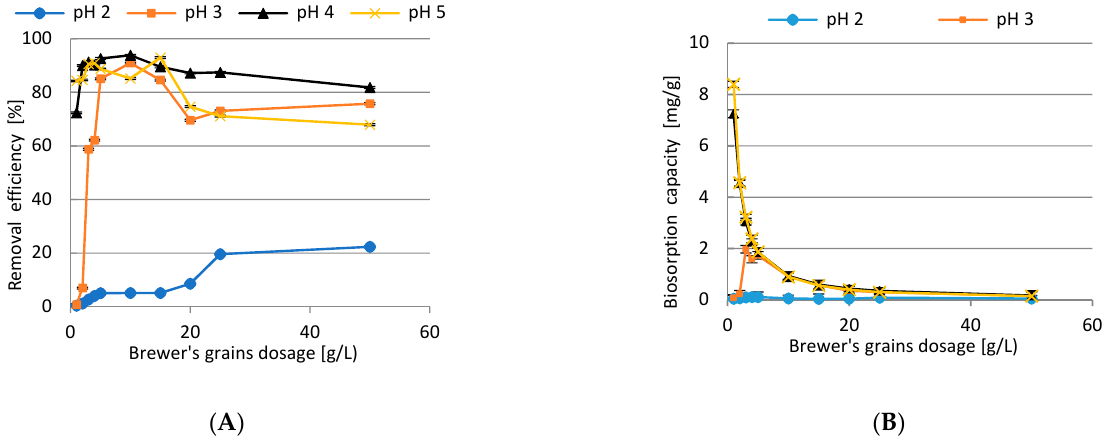
Figure 11. The impact of BG dosage on biosorption efficiency ( A ) and biosorption capacity ( B ) of Cd(II) ions.